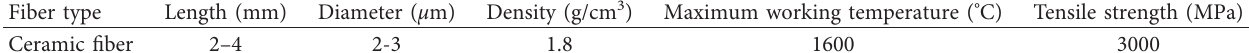
Table 3: Performance indexes of ceramic fibers.